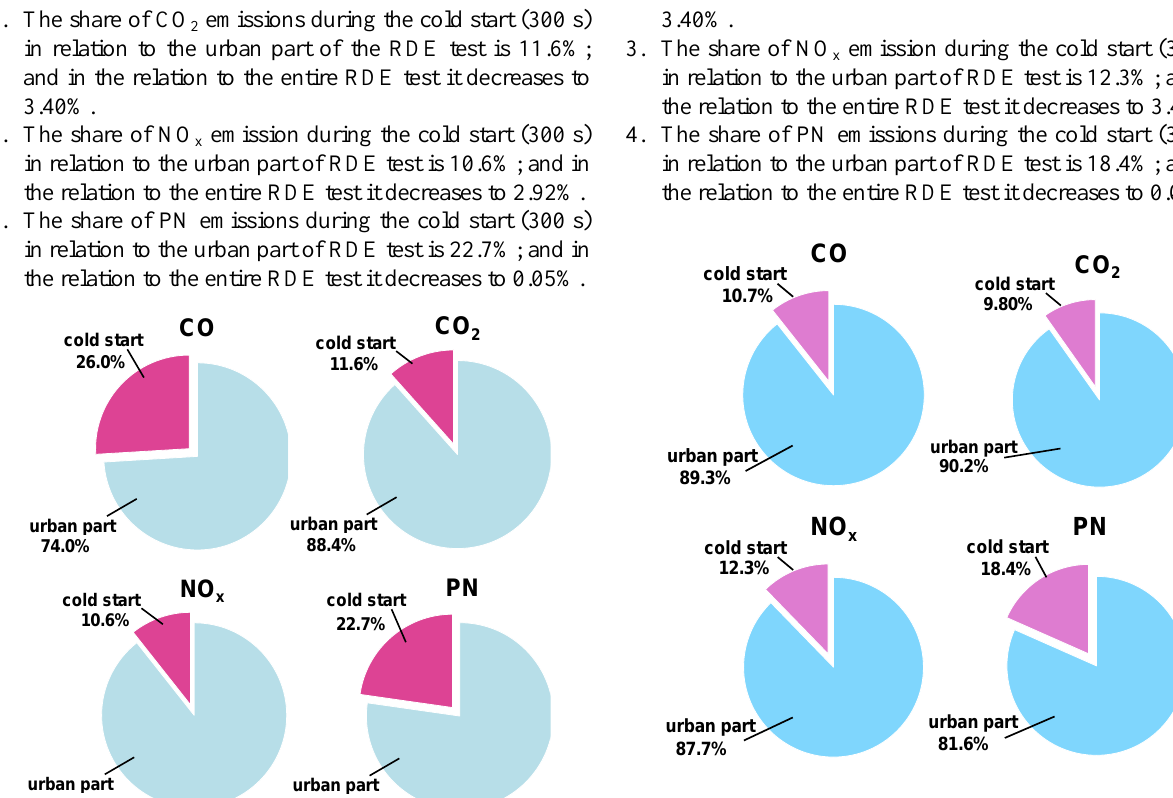
Fig. 14. Share of CO, CO 2 , NO x and PN emissions in urban section during cold start at 25ºC